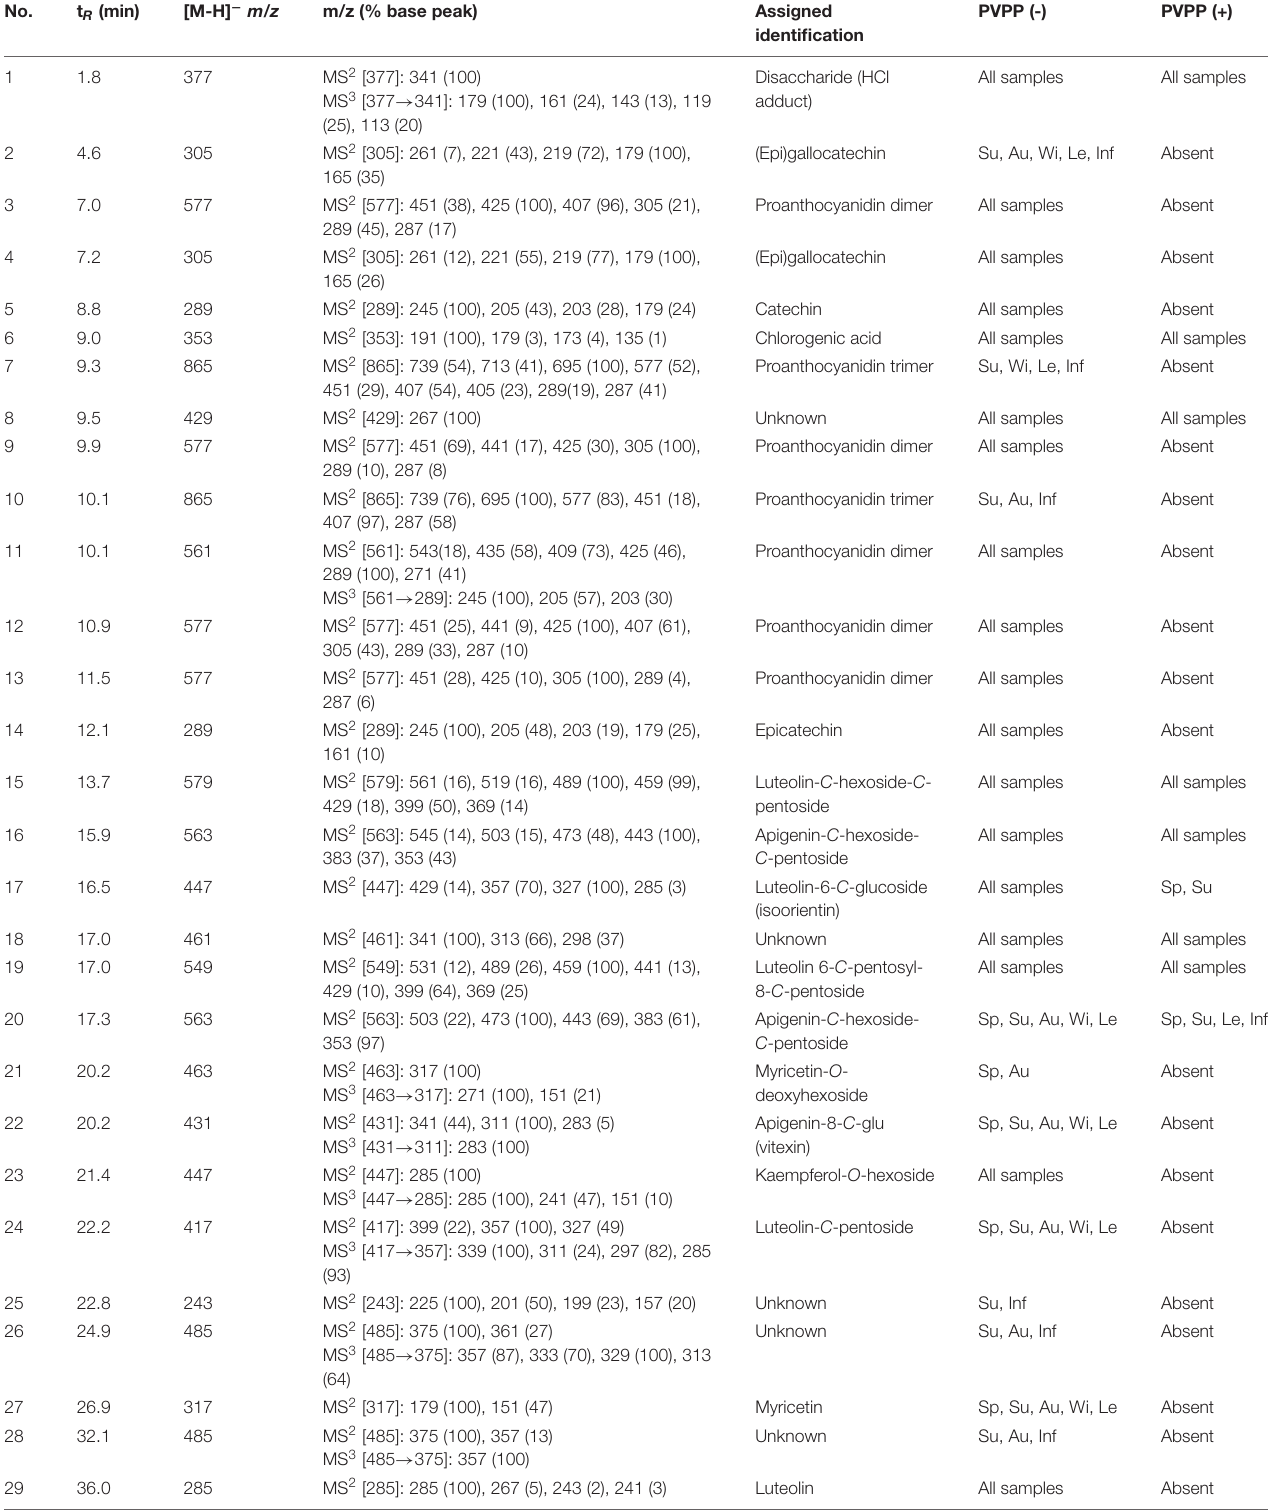
TABLE 3 | Characterization of the polyphenolic compounds found in the analyzed extracts of Cladium mariscus (L.) Pohl (sawgrass).